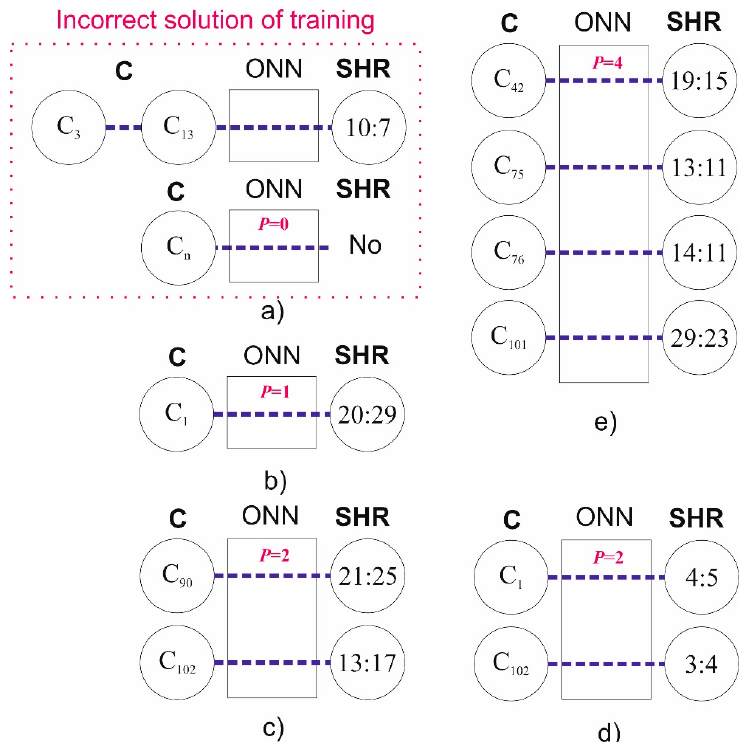
Figure 13. Training results at various values of current I ON : examples of incorrect solutions of training ( a ) and solutions of problem I ( b ); examples of correct solutions of problem II ( c – e ). The complete list of the model parameters is presented in Supplementary Materials (Data2.txt). Electronics 2019 , 8 , 75